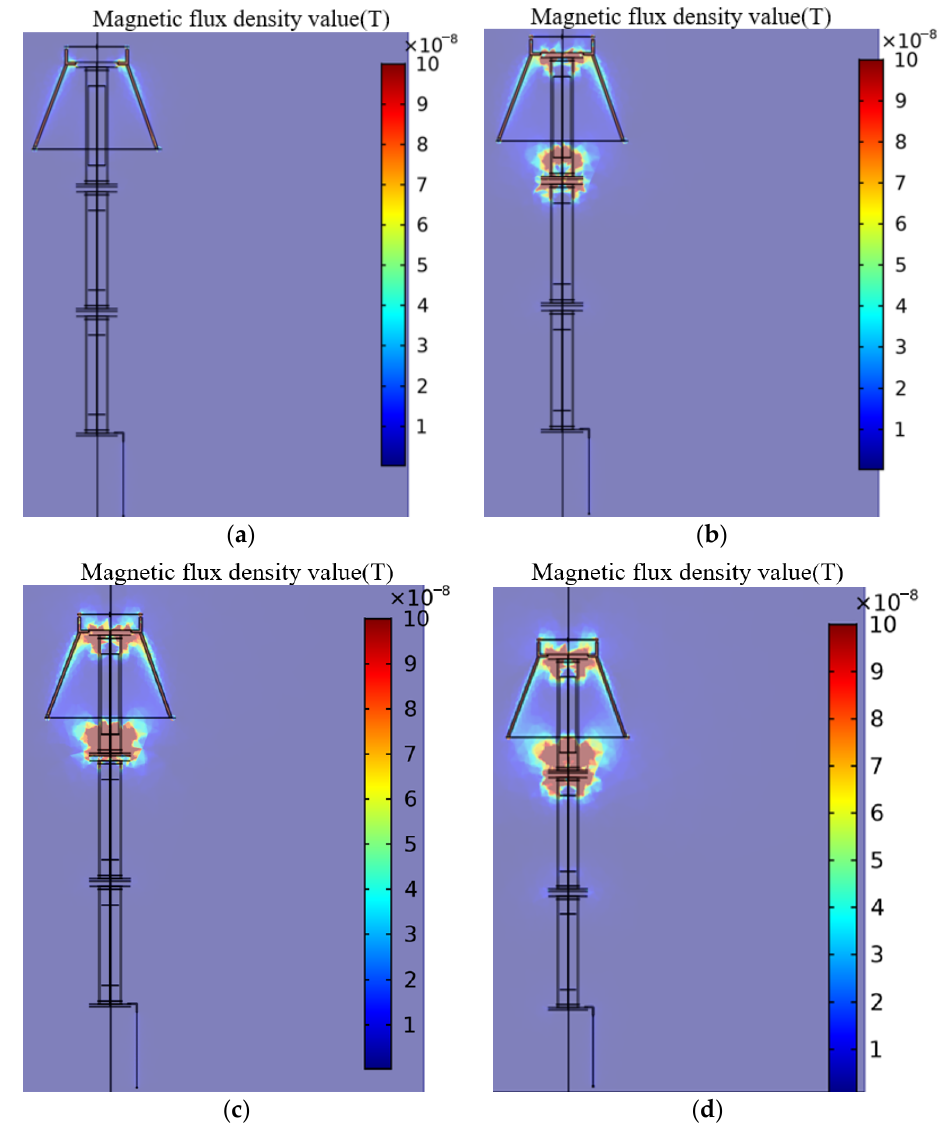
Figure 13. Magnetic field distribution at different degrees of moisture. ( a ) dry condition; ( b ) slight wetness; ( c ) moderate wetness; and ( d ) severe wetness.